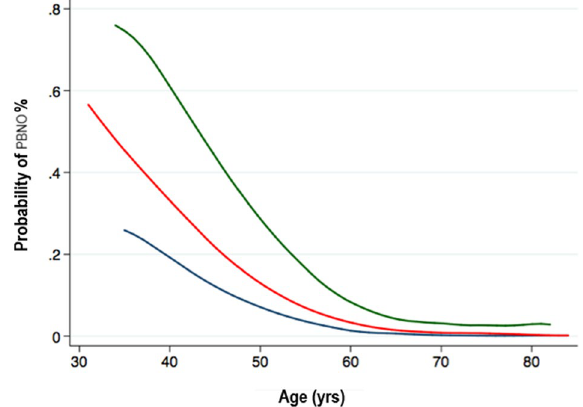
Figure 1. Probability of PBNO according to age. The green line represents patients with severe LUTS; the red line represents patients with moderate LUTS, the blue line represents patients with mild LUTS. Keys: PBNO = primary bladder neck obstruction; LUTS = lower urinary tract